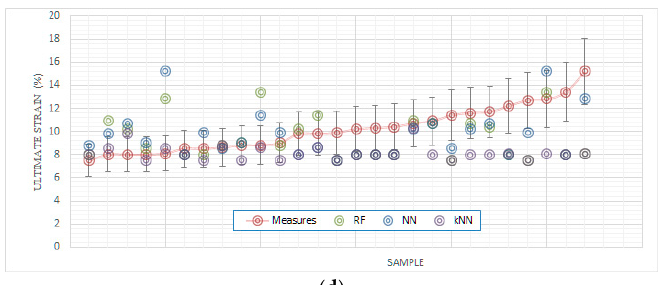
Figure 1. Metallurgical properties (( a ) Ultimate Tensile Strength (UTS), ( b ) Yield Strength (YS), ( c ) Ultimate Strain ( ε ), ( d ) Young’s modulus ( E )) in the case of Spheroidal Graphite Iron (SGI), as measured and predicted.